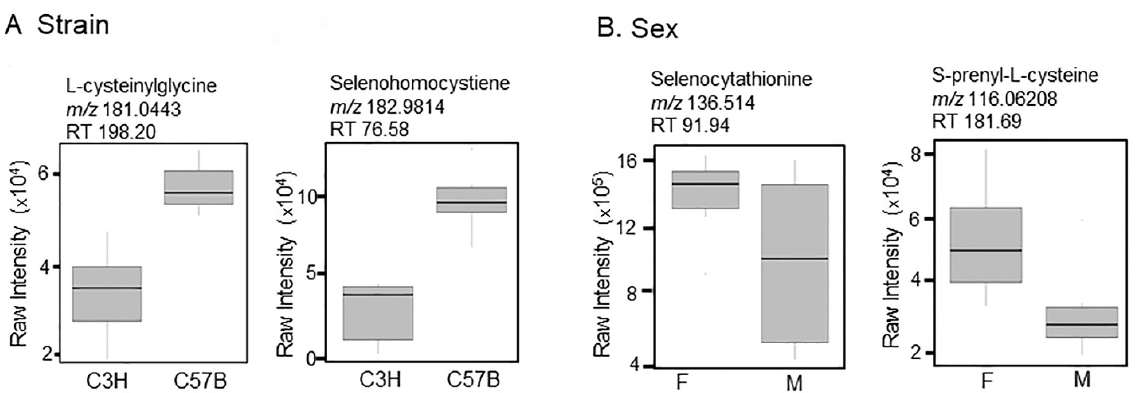
Figure 2. Metabolites identified within the methionine, cysteine, and selenocysteine pathways. Selected metabolites which differed between ( A ) strain, ( B ) sex, and ( C ) interaction were plotted. 3.2. Differences in Transcriptome Transcriptomic data yielded differentially expressed transcripts: 1418 between strains, 484 between sexes, and 383 at the interaction between sex and strain (Table S3). The results of the two-way hierarchical cluster analyses are presented using heatmaps (Figure 3). Strain (Figure 3A) resulted in two main clusters for C3H and C57B. Expression was different between strain C3H and C57B, with 703 genes higher and 715 genes lower in C3H than C57B. Sex (Figure 3B) resulted in two main clusters between males and females. The transcriptome analyses yielded differences between males and females, with 196 genes higher and 288 genes lower in males than females. The interactions (Figure 3C) yielded four main clusters: C3HM, C3HF, C57BM, and C57BF. The PLS-DA score plots show that separation according to interactions in component 1 is 59.34% and that for component 2 is 40.66% (Figure 3D). The gene set enrichment analysis (Table S4) of transcripts among strain, sex, and interaction are presented using bubble plots (Figure 3E). The size of the bubble correlates with the size of the absolute enrichment score (ES), which represents both increased and decreased expression and uses an absolute score of change for statistical analyses. Across strain, sex, and interaction, the unique and common transcriptomic pathways are displayed in a Venn diagram (Table S4).